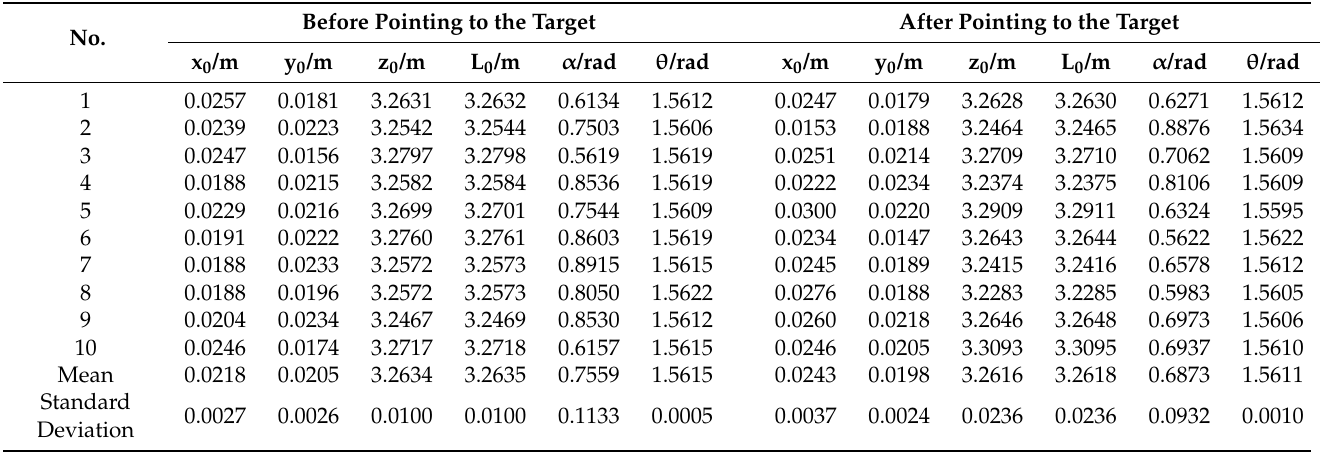
Figure 8. Target and background 3D information and image: ( a , b ) 3D point clouds and their front view before pointing to the target, and ( c , d ) 3D point clouds and their front view after pointing to the target; and ( e ) the image before pointing to the target (the yellow dotted line represents the target, and the red dotted line represents the scanning center), and ( f ) the image after pointing to the target. Table 2. Coordinates, distance, azimuth, and pitch of the target centroid.